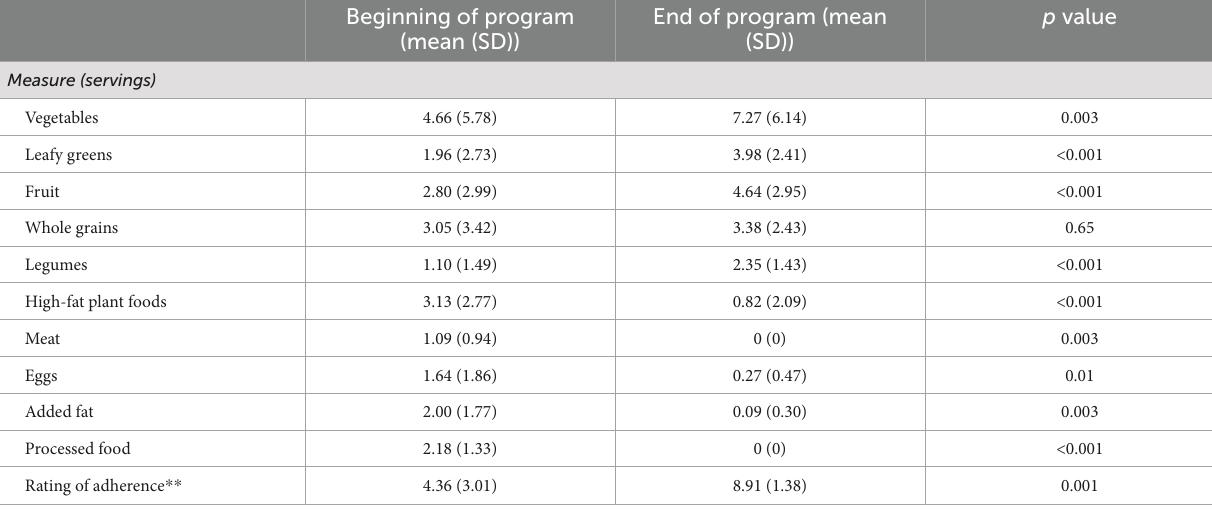
TABLE 2 Changes in dietary components * during the Jumpstart program ( n =